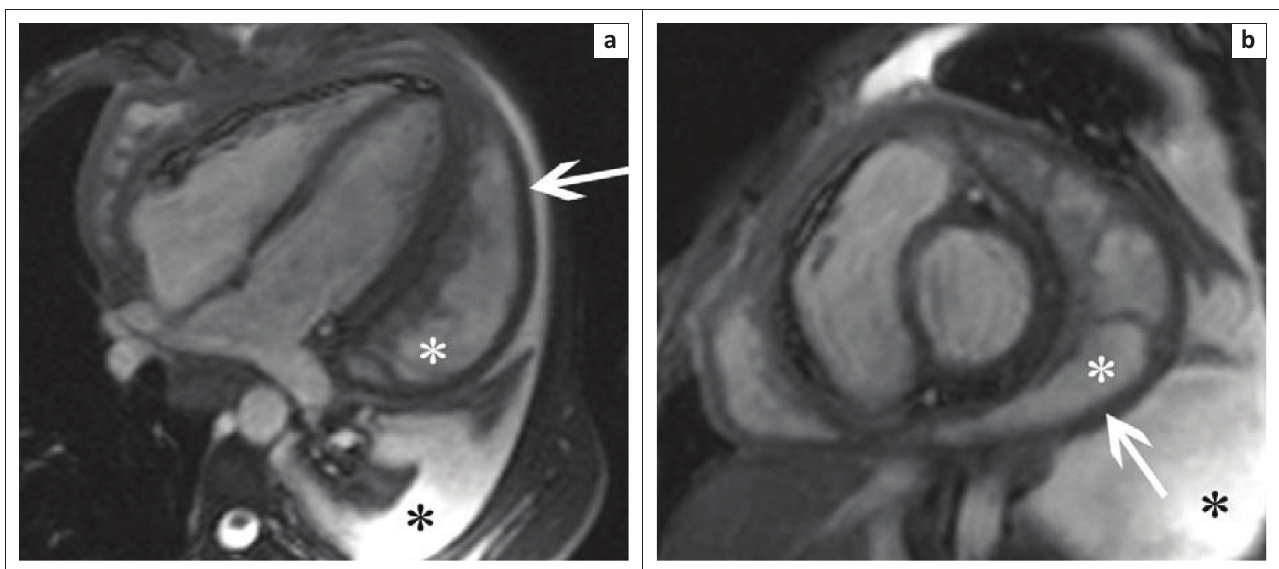
FIGURE 6: CMR SSFP images (a and b) show marked pericardial thickening (white arrows) and a large pericardial effusion containing organised fibrin strands (white asterisk). A large left-sided pleural effusion is also evident (black